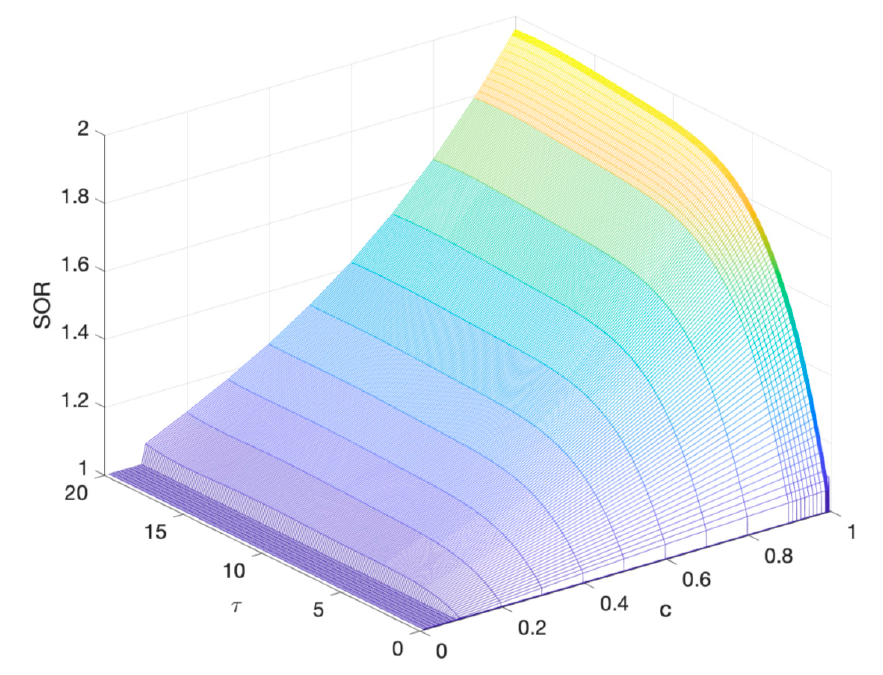
Figure 3. Successive overrelaxation (SOR) distribution.